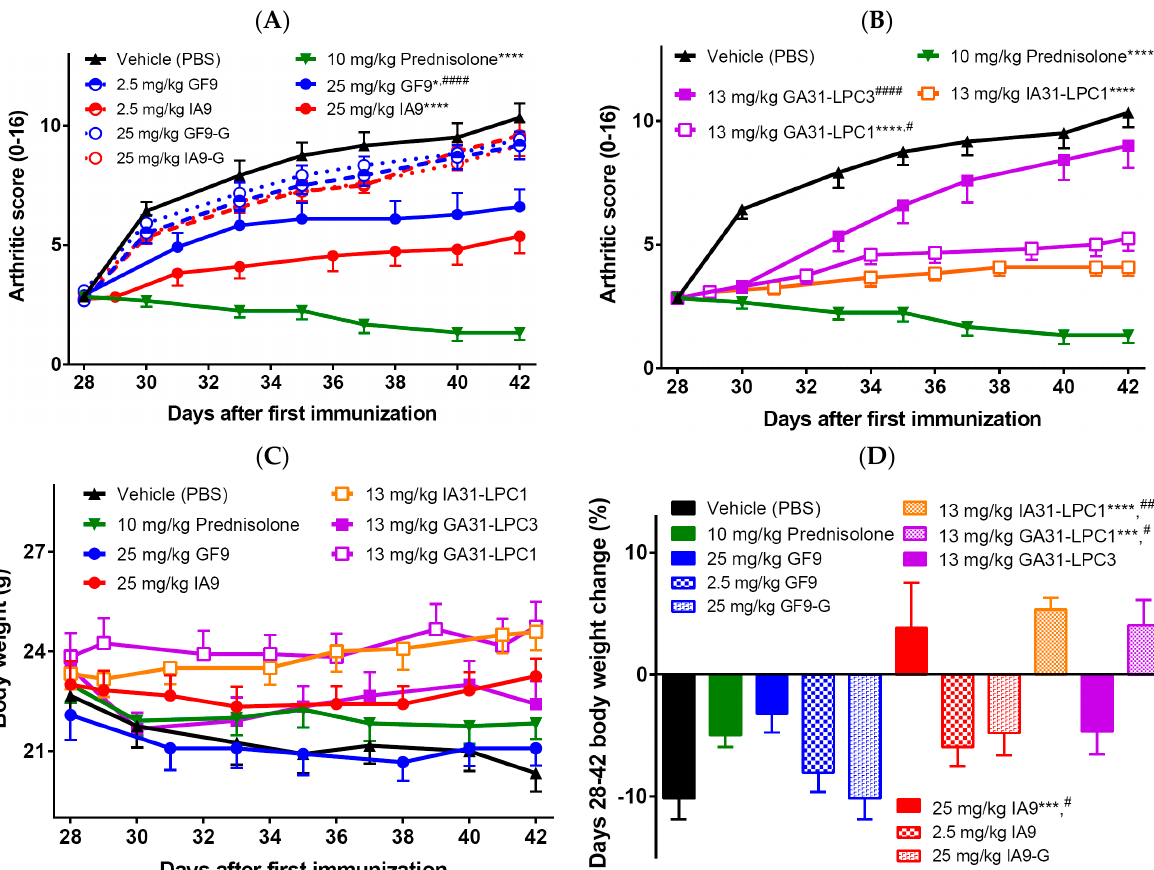
Figure 2. Effect of therapeutic treatment with free ( A ) and LPC-bound ( B ) IA9 and GF9 sequences on the severity of collagen-induced arthritis ( A,B ) and body weight ( C,D ). Data are shown as mean ± SEM ( n = 12 mice per group). *, p < 0.05; ***, p < 0.001; and ****, p < 0.0001 versus vehicle. # , p < 0.05; ## , p < 0.01; and #### , p < 0.0001 versus prednisolone.